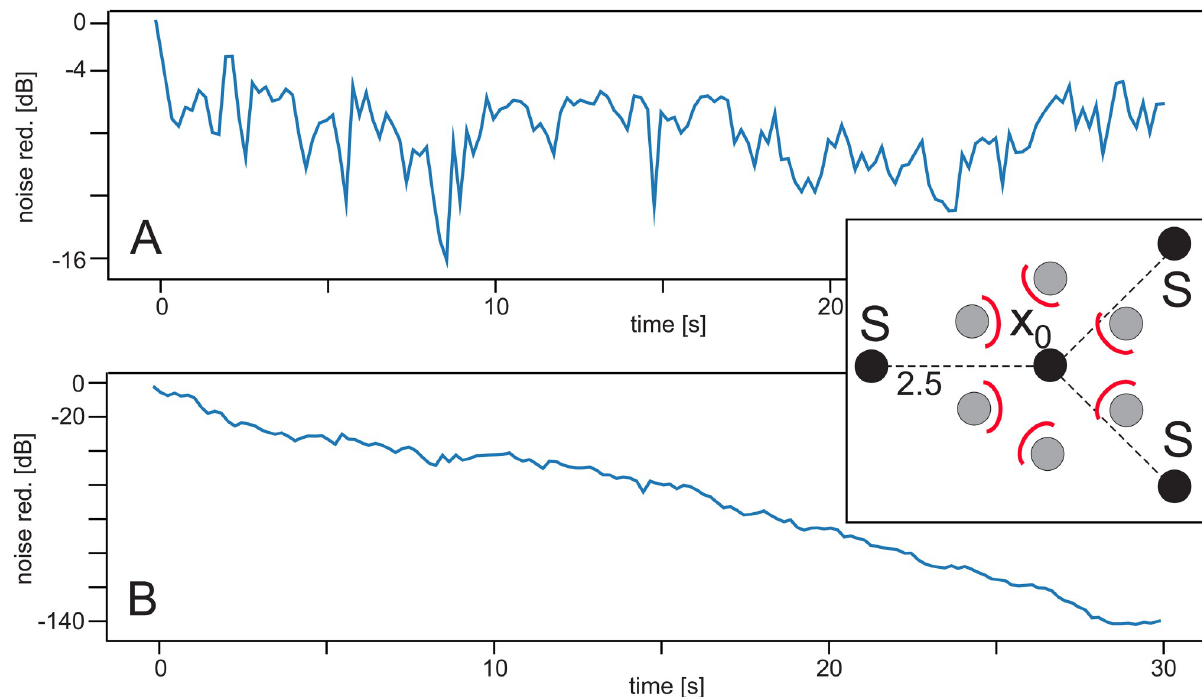
Fig 6. Effect of shielding when using different noise sources. Learning rate: μ = 7.5 × 10 − 8 . Configuration is shown as inset in panel B, small red arcs show the shields against the non-predictive noise sources. Distance from S to x 0 was 2.5 m . A Noise reduction without shielding, B with shielding.